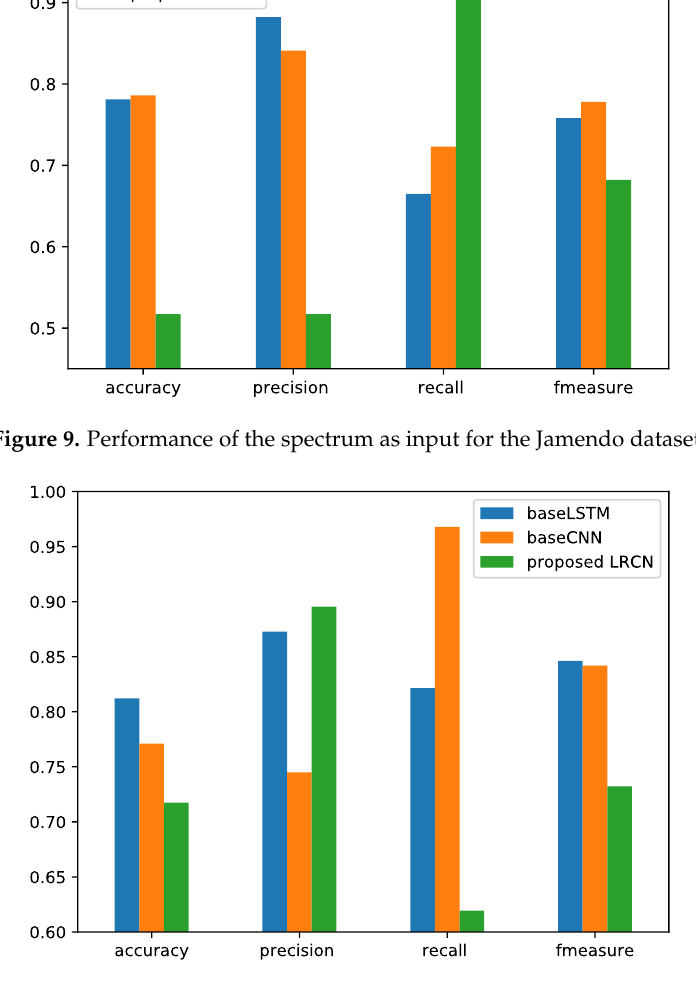
Figure 10. Performance of the spectrum as input for the RWC